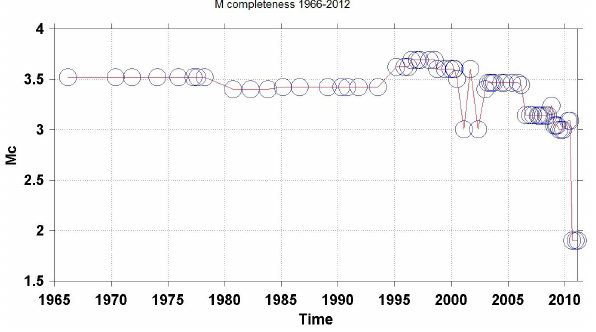
Fig. 7. The temporal variation of the M c in NOA seismicity cata- logue for